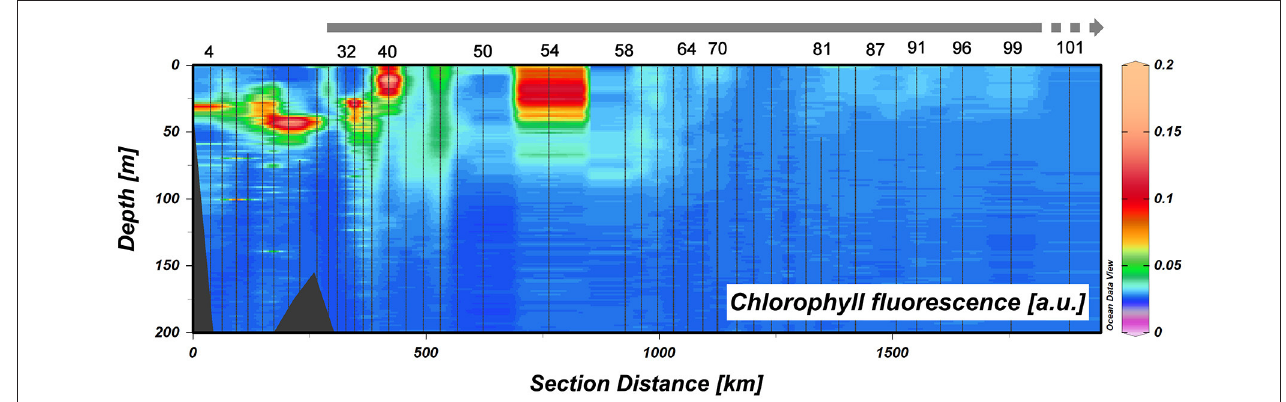
FIGURE 9 | Fe* in nM in the upper 500m of Transects 1-3 according to two scenarios. Scenario 1 and scenario 2. The black contour indicates where Fe* ≤ 0, with an equidistance of − 0.1nM. Station numbers and basin names are given (see Figure 1 ).